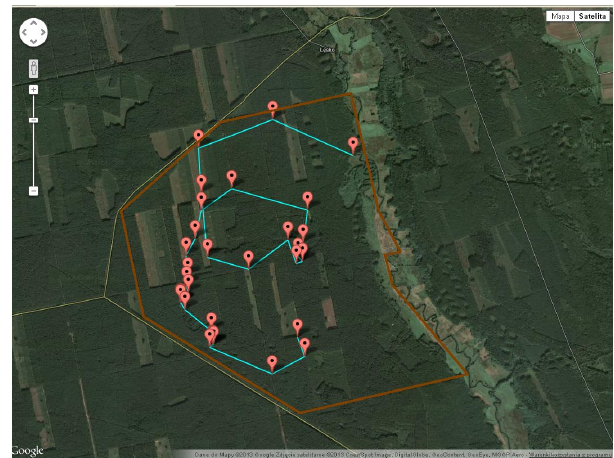
Figure 1. An example of the tracks used by the horses within the nature reserve area. Map data © 2013 Google, Satellite im- age © 2013 Cnes/Spot Image, DigitalGlobe, GeoContent, GeoEye, MGGP